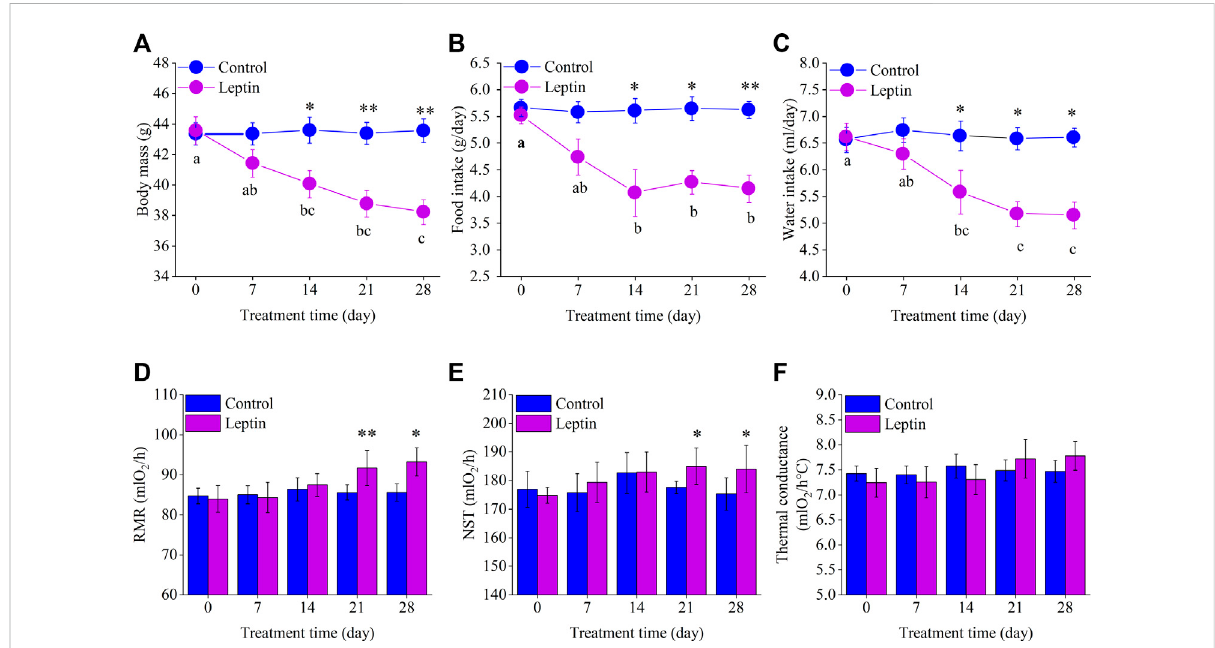
FIGURE 2 Effect of leptin on body mass (A) , food intake (B) , water intake (C) , RMR (D) , NST (E) and thermal conductance (F) in Eothenomys miletus. Different letters (a – c) indicate signi fi cant differences ( p < .05) within the leptin group; *: p < .05, **: p < .01 indicates a signi fi cant difference between the leptin and control